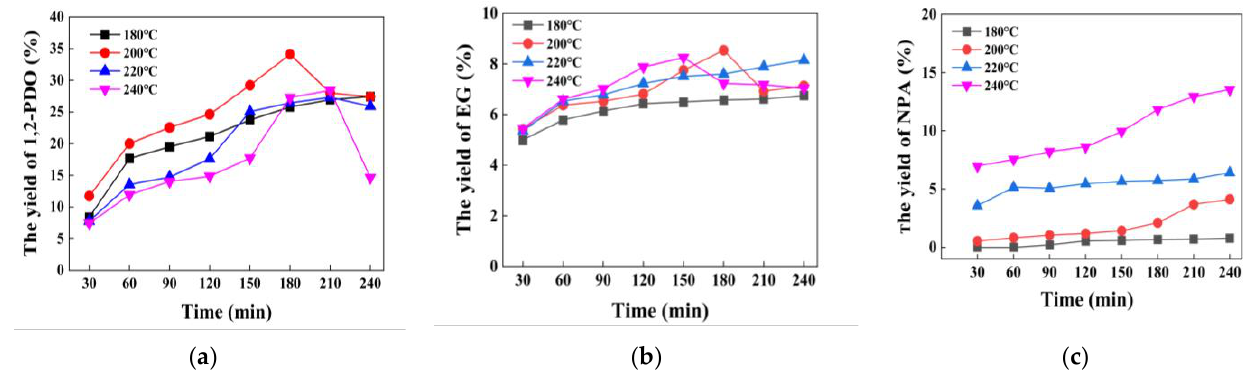
Figure 5. The effect of reaction temperature and reaction time on glucose hydrogenolysis into ( a ) 1,2-PDO; ( b ) EG; ( c ) NPA. Reaction condition: catalyst (200 mg), glucose (11.25 mg/mL, 10 mL) and H 2 (initial 6 M Pa).